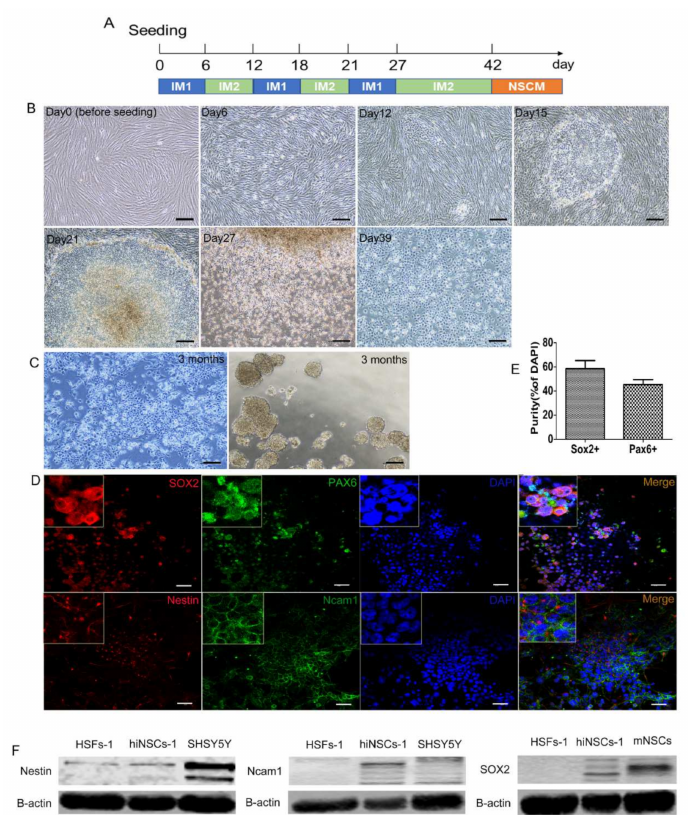
Figure 1. Generation of human iNSCs from fibroblasts by small molecules. ( A ) Scheme of induction procedure. See Methods and Supplemental Experimental Procedures for detailed protocol. ( B ) Phase contrast images of cells during induction time, scale bars are 200 µ m. ( C ) Morphology of hiNSCs-1 in monolayer culture and suspension culture, scale bars are 200 µ m. ( D ) hiNSCs-1 stained for neural stem cell makers, SOX2, Nestin, PAX6, and Ncam1, scale bars are 40 µ m. ( E ) The percentage of Sox2+ and Pax6+ cells in total cells at the time of quantification (means ± SEM, cell counting was from 3 triplicate samples). ( F ) Representative immunoblots for SOX2, Nestin (upper band), and Ncam1 in different cells, B-actin (beta-actin) was used as a loading